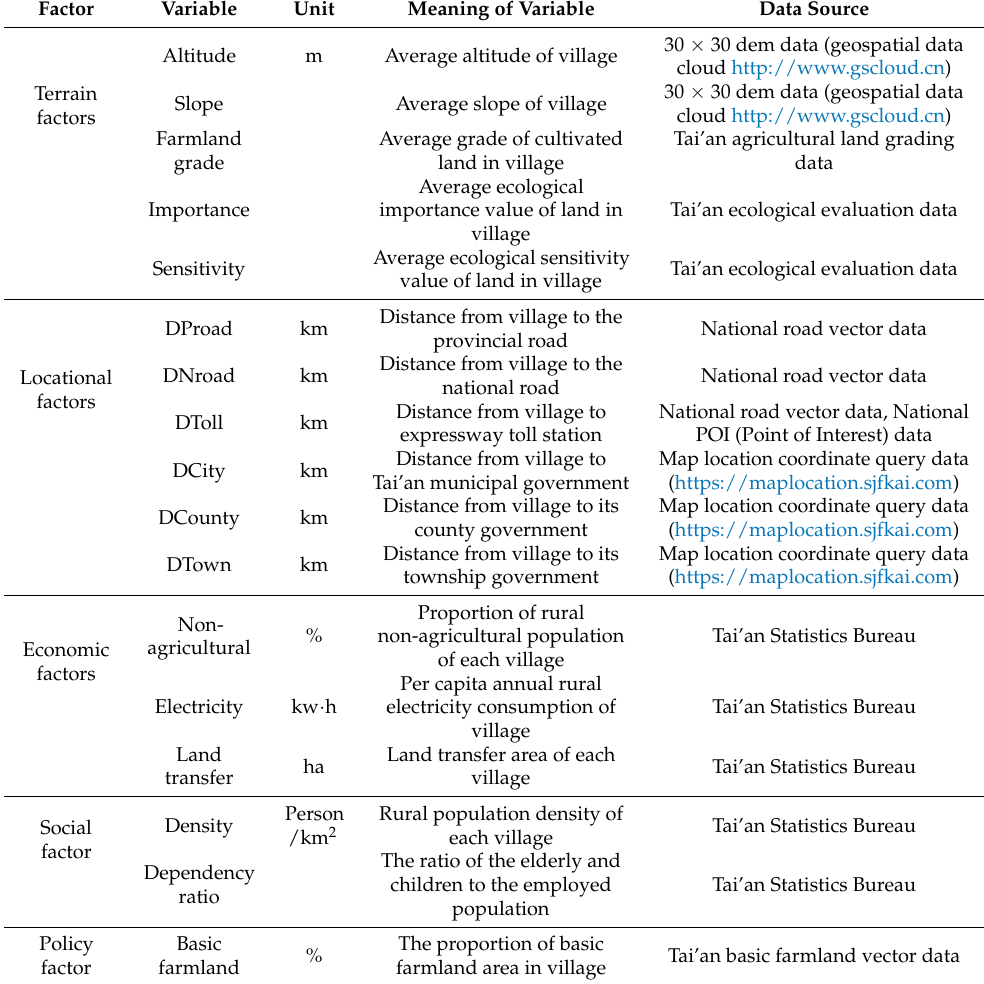
Table 1. Research variables and data